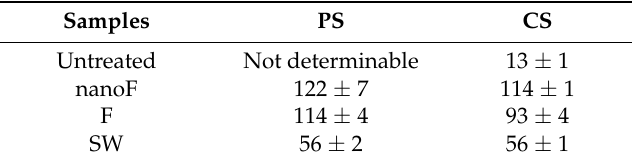
Table 7. Oil–stone static contact angle ( ◦ ) measured on untreated and treated PS and CS stone surfaces, with the indication of standard